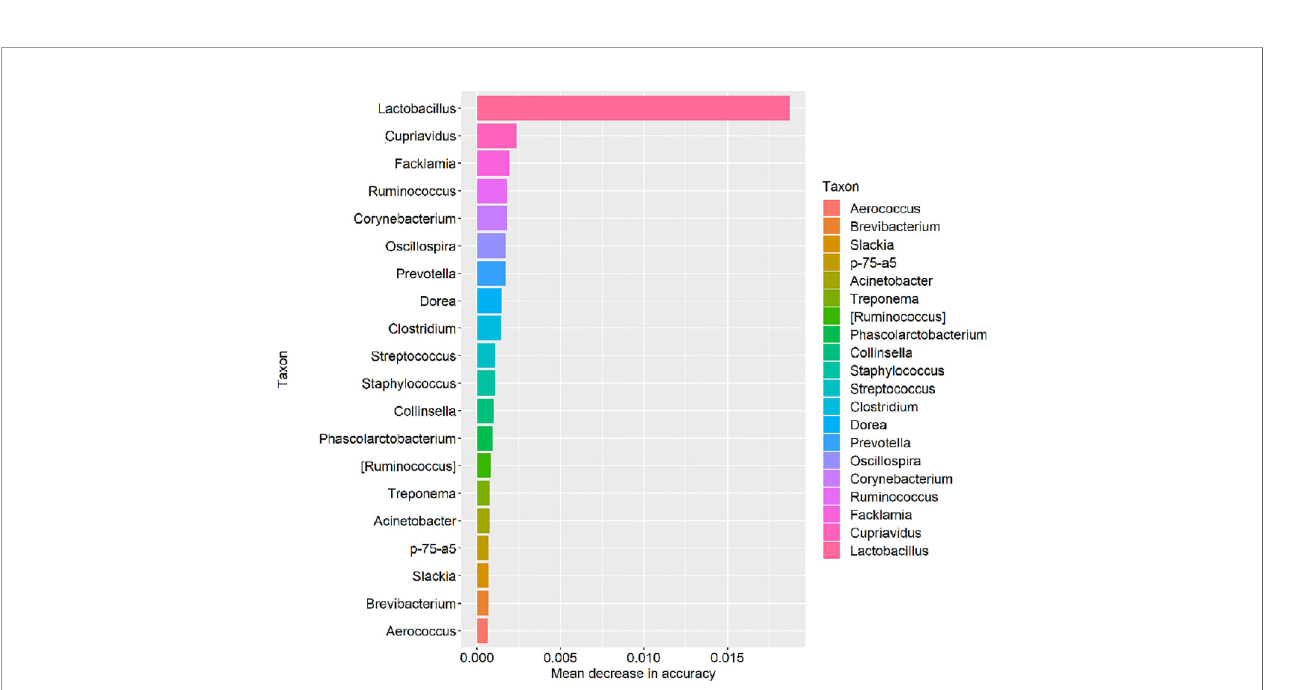
FIGURE 8 | Based on the relative abundances of bacterial taxa, random forest regression analysis was taken and the top 20 taxons of genus in mean decrease in accuracy were visualized by R software.